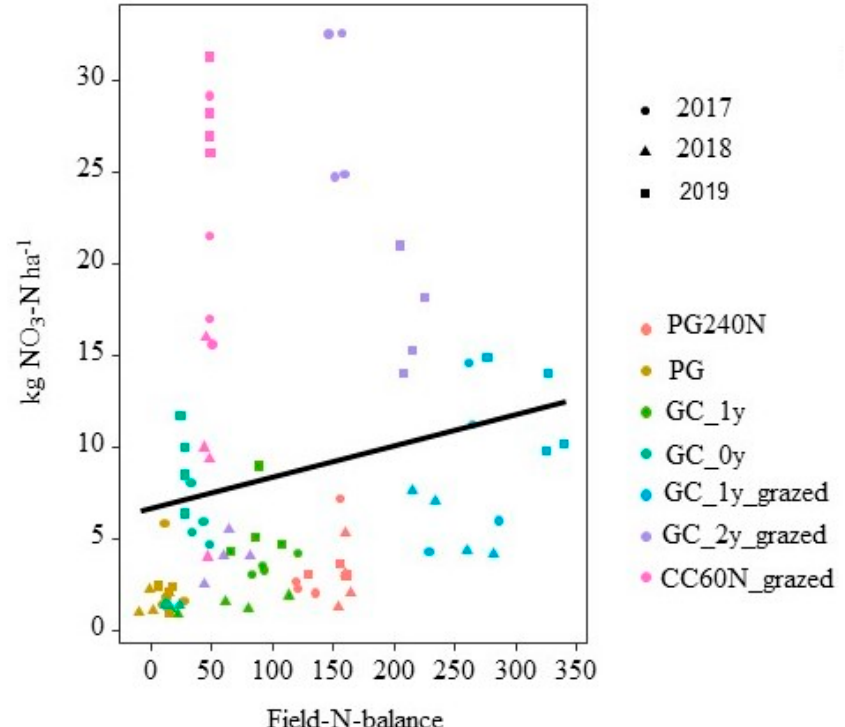
Figure 5. The relationship between the field-N-balance and NO 3 -leaching (kg NO 3 -N ha − 1 ) of the different systems used in the